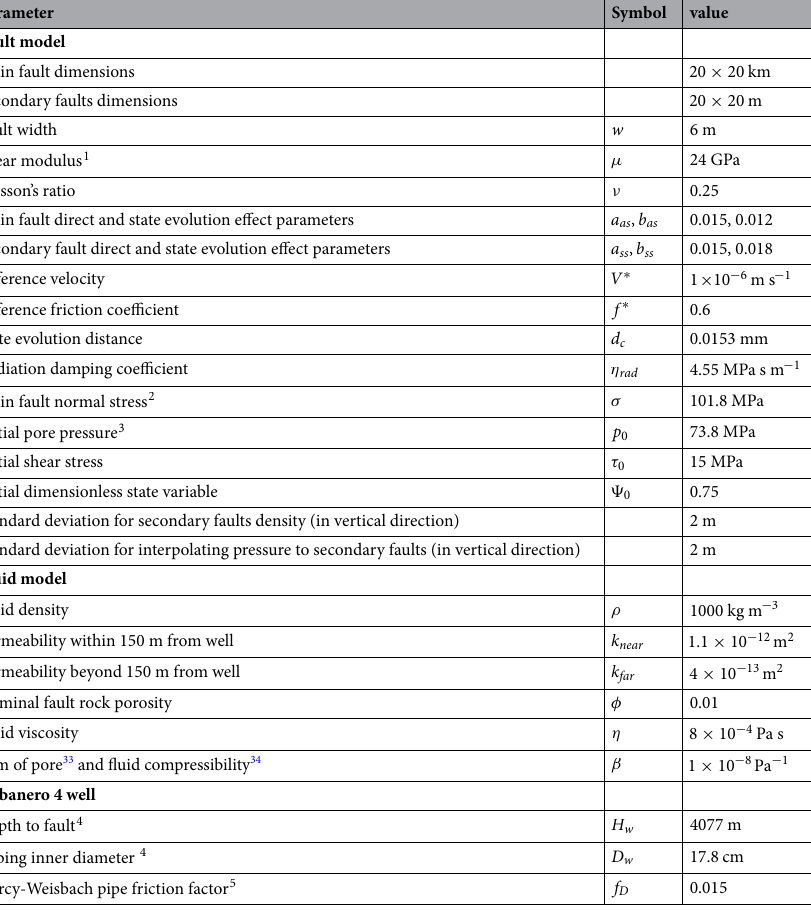
Table 1. Parameters used for hindcasting injection induced seismic and aseismic slip [1] Shear modulus of granite 35 [2] Derived from S Hmax and S v , which are obtained from geomechanical modeling 22 [3]